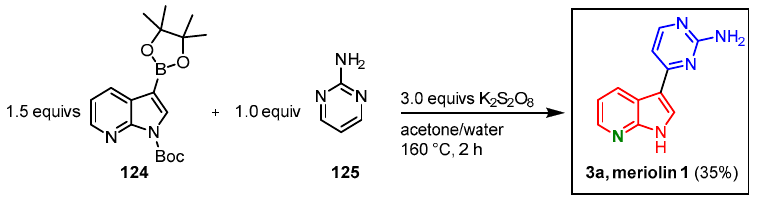
Figure 34. Metal-free synthesis of meriolin 1 via CH-activation by Singh [72].